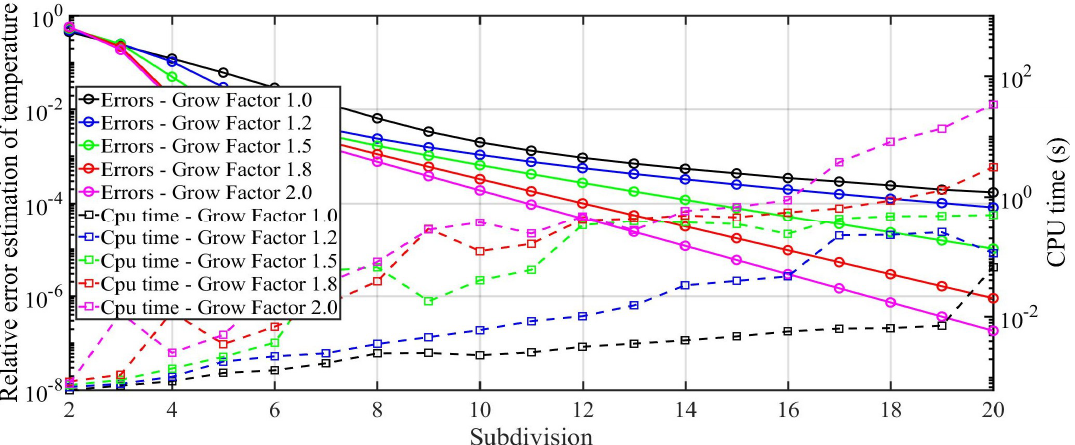
Figure 9. Absolute maximum temperature error estimations of the outer surface (Case 1).